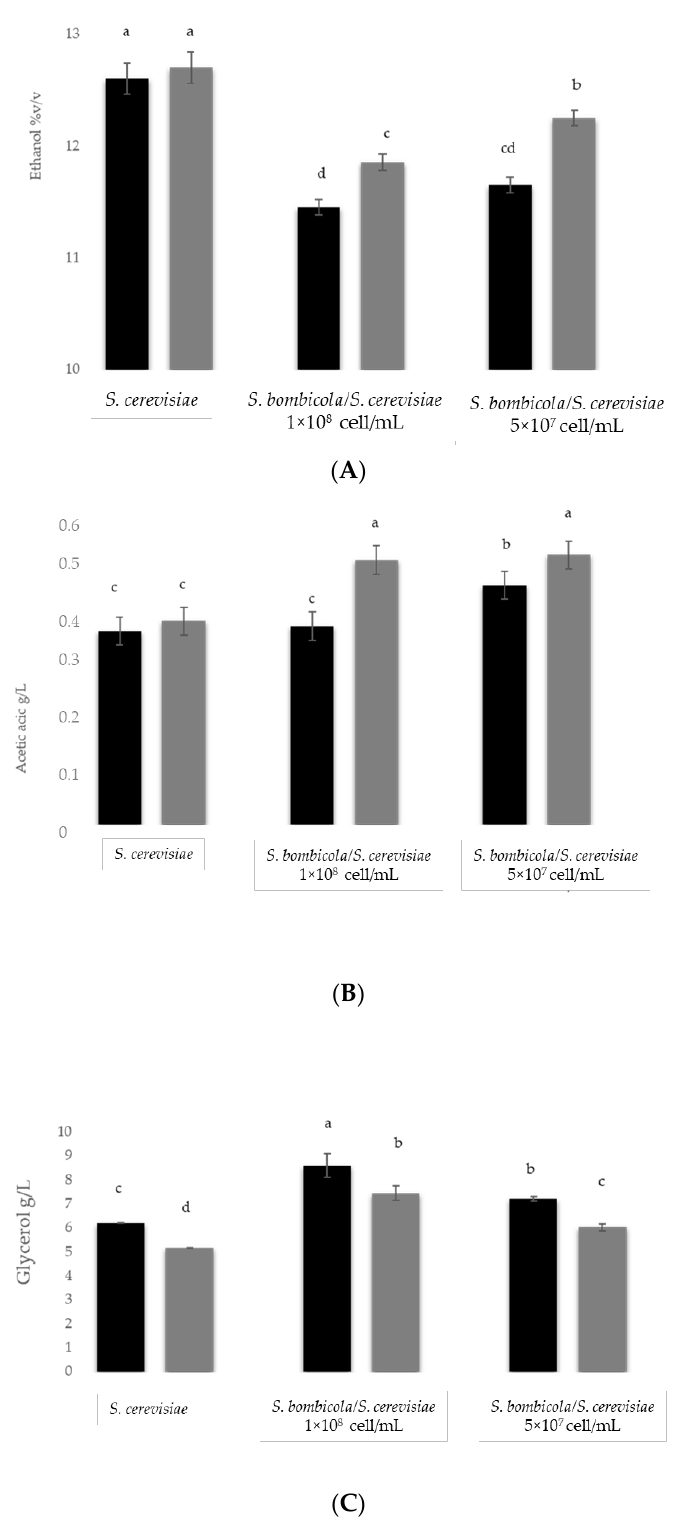
Figure 1. Ethanol content, ( A ) volatile acidity, ( B ) and glycerol content ( C ) of preliminary screening in sequential fermentation in static and agitation condition in Synthetic Grape Juice . Agitation condition; static condition. Data with different superscript letters ( a,b,c,d ) are different according to Duncan tests (0.05%).